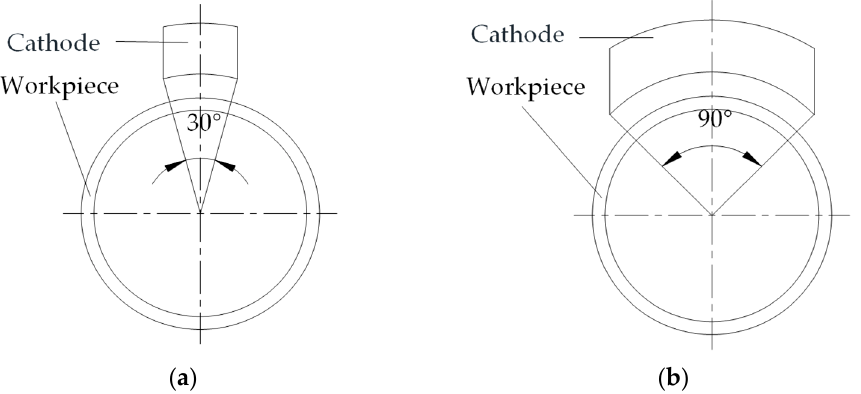
Figure 7. Two kinds of cathode coverage: ( a ) cathode coverage is 30°; ( b ) cathode coverage is 90°.